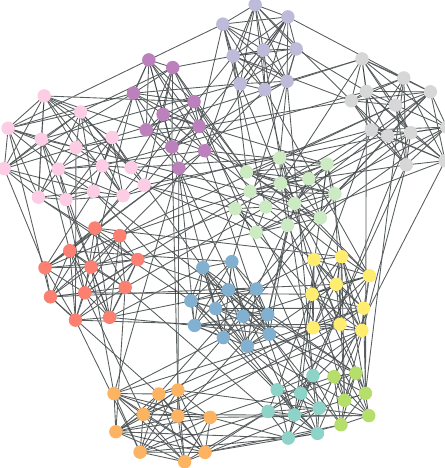
FIG. 7. Network of games between American college football teams (NCAA college football 2000) [51]. The node colors show the fit of the SBM and SBM/TC, both yielding the same B ¼ 11 communities. The SBM yields a description length of Σ SBM ¼ 1761 . 1 nats, and the SBM/TC, Σ 1767 . 6 SBM = TC ¼